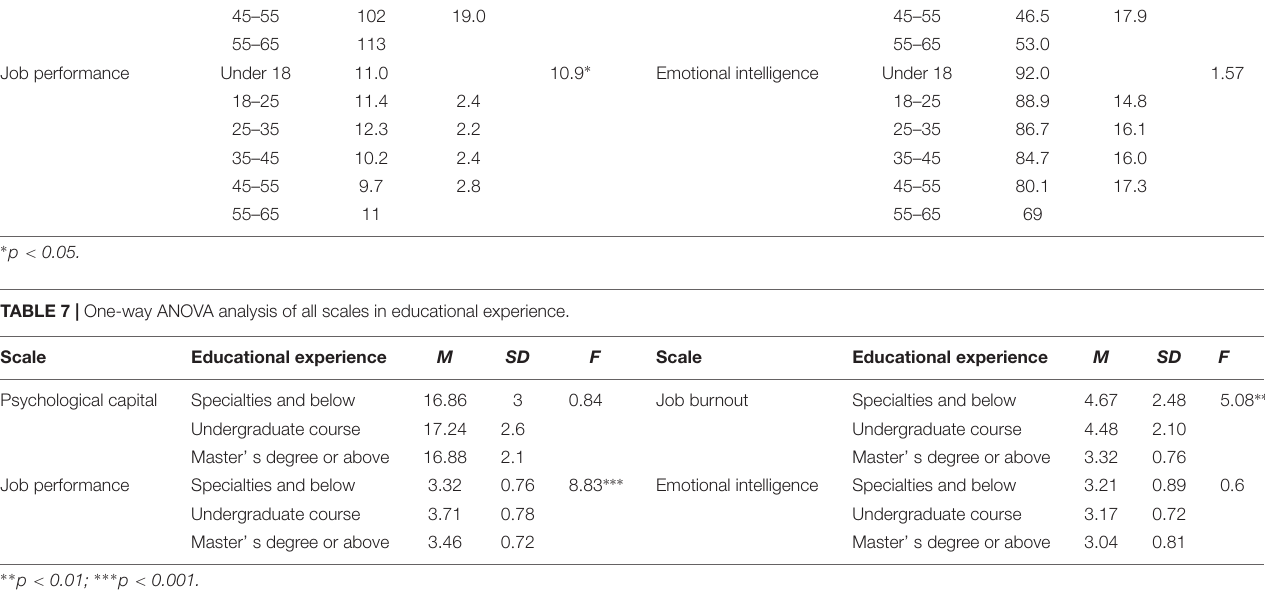
TABLE 6 | One-way ANOVA analysis of all scales in age. Scale